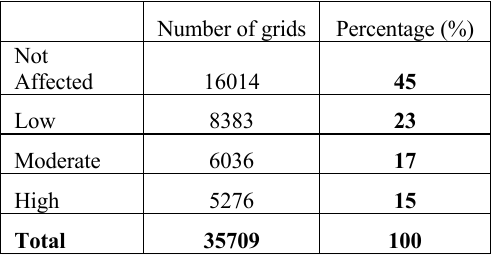
Table 7. Total number of grids in Masinloc, Zambales